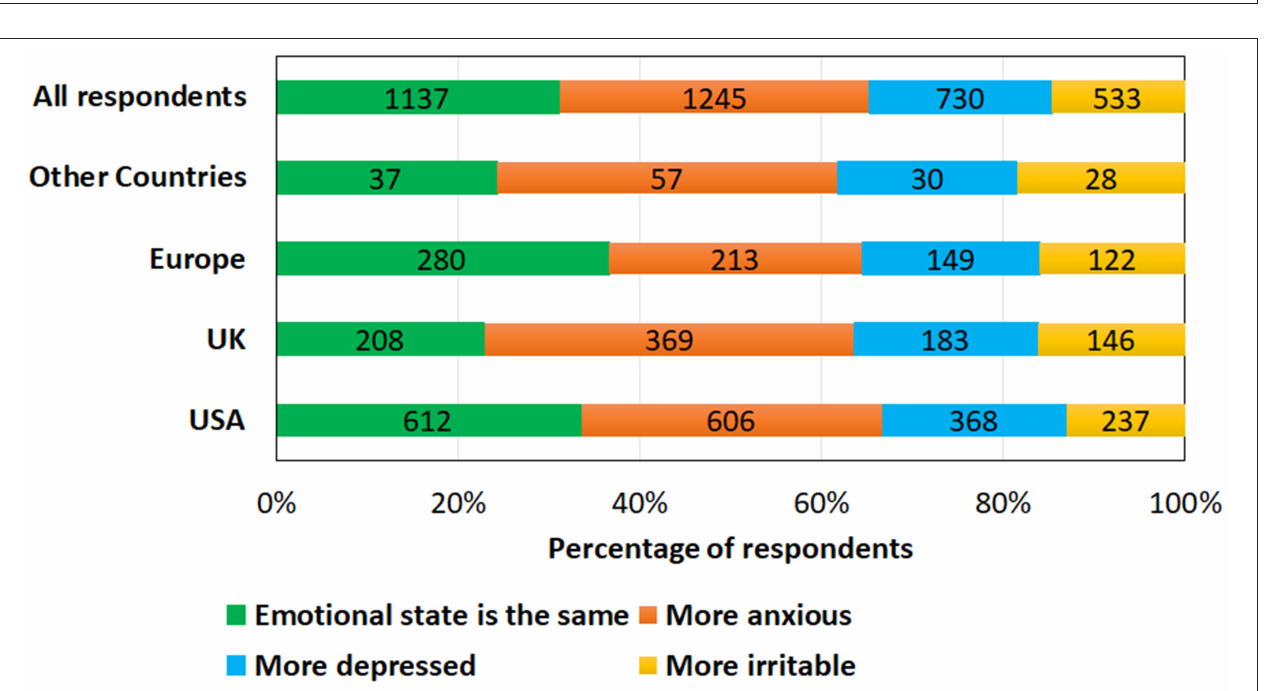
FIGURE 6 | Comparison of emotional state during the COVID-19 pandemic across different locations.